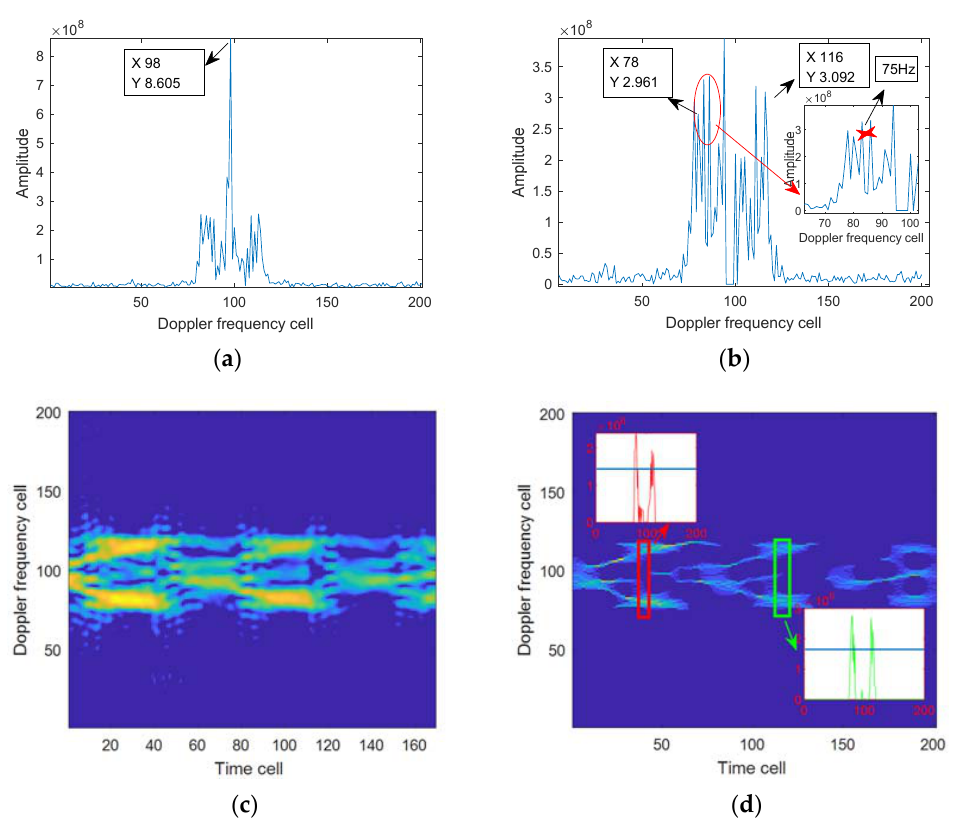
Figure 10. Data processing of helicopter. ( a ) FFT, ( b ) analysis of ff BWm Δ ,ˆ , ( c ) STFT, ( d ) FSST and rotor number analysis.